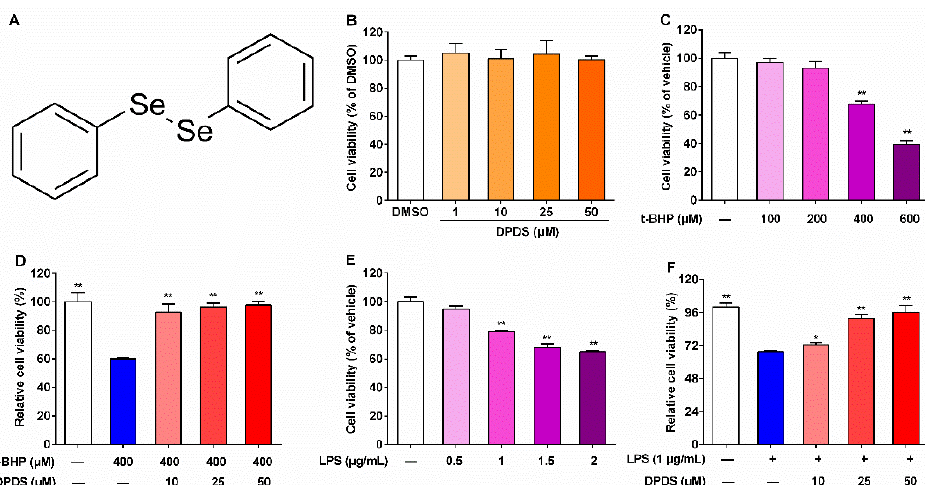
Figure 1. DPDS protected HBZY-1 cells against t-BHP-induced injury. The HBZY-1 cells were exposed to indicated concentrations of agents for 24 h, and cell viability was detected by a CCK-8 kit. ( A ) Chemical structure of DPDS. ( B ) Cell viability of HBZY-1 cells after treatment with indicated concentrations of DPDS for 24 h ( n = 3). Reference: DMSO group. ( C ) t-BHP-induced cytotoxicity in HBZY-1 cells ( n = 3). Reference: vehicle group. ( D ) Effects of DPDS on t-BHP-induced cytotoxicity ( n = 6). Reference: the 400 µ M t-BHP group. ( E ) LPS-induced cytotoxicity in HBZY-1 cells ( n = 6). Reference: vehicle group. ( F ) Effects of DPDS on LPS-induced cytotoxicity ( n = 6). Reference: the 1 µ g/mL LPS group. Data are presented as means ± SEM. * p < 0.05, ** p < 0.01.